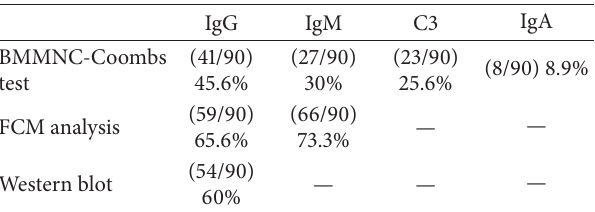
Table 1: Detection of autoantibodies to BM hemopoietic cells in IRP